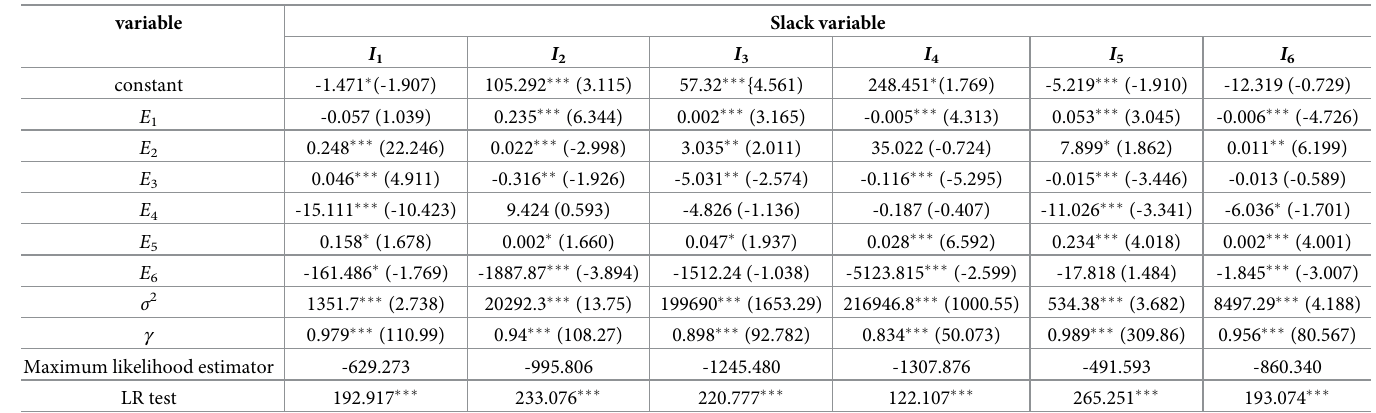
Table 3. SFA regression results.